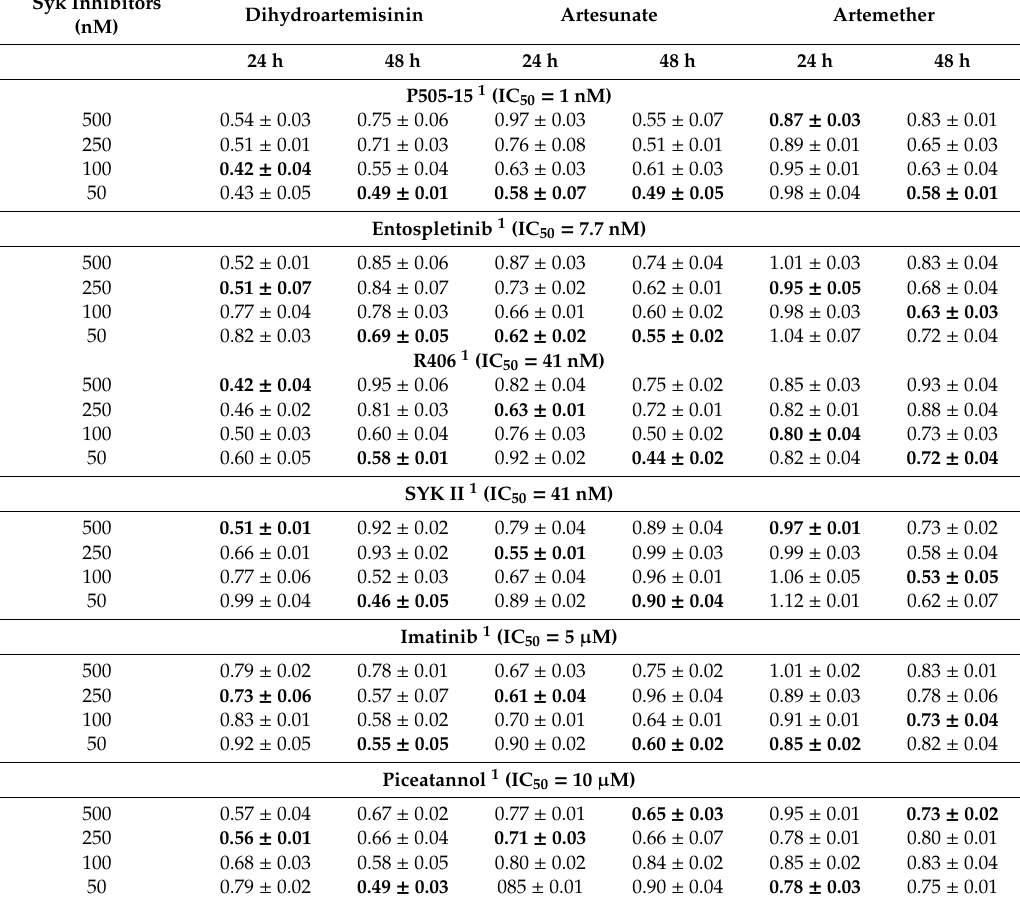
Table 1. Combination index value (CI) 24 and 48 h after treatment.